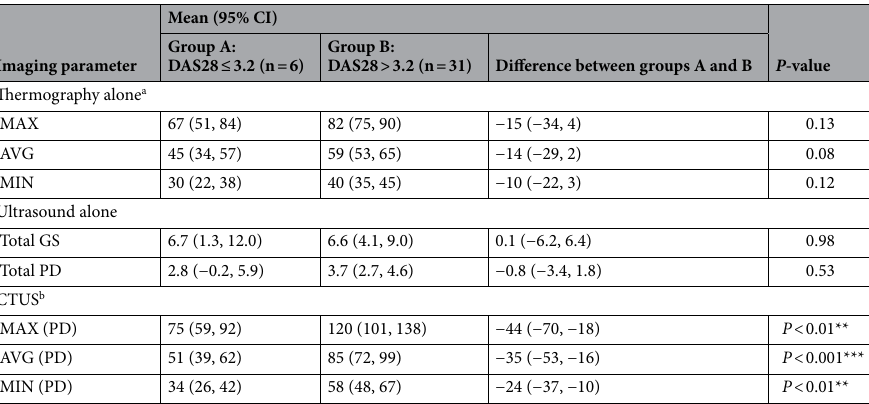
Table 1. Comparison of results from imaging parameters between DAS28 patient groups. GS grey-scale, PD power Doppler, CTUS combined thermal and ultrasound. a MAX, AVG and MIN are thermographic parameters derived from summing the temperature differences between the respective maximum (T max ), average (T avg ) and minimum (T min ) temperatures at the joints with a control temperature for each patient b MAX (PD), AVG (PD) and MIN (PD) are combined thermal and ultrasound imaging results derived by multiplying MAX, AVG and MIN by a factor of 2 when a patient’s total ultrasound power Doppler joint inflammation score exceeds the median score. Otherwise, MAX (PD), AVG (PD) and MIN (PD), remained unchanged from the MAX, AVG and MIN. Statistically significant: ** P < 0.01, *** P < 0.001.